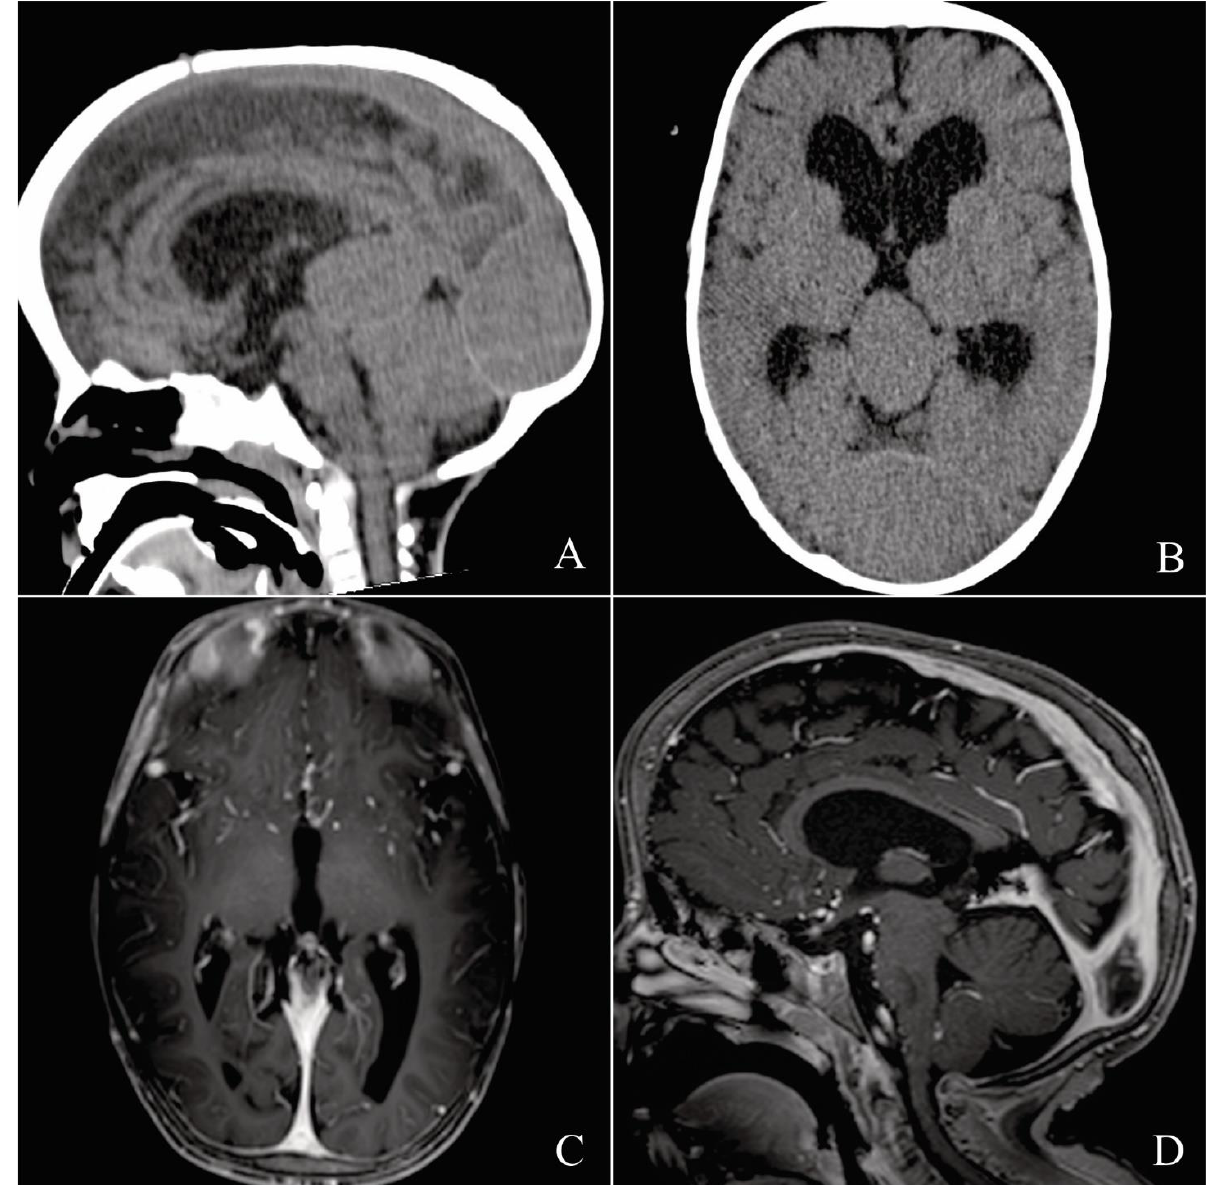
Figure 3 - Computed tomography scan of the brain at admission, sagittal view (A), and axial view (A) showing a dilated vein of Markowski and a dilated torcula. Magnetic resonance image of the brain 12 months after treatment axial view (C), and sagittal view (D) showing absence of the vein of Markowski and a reduction in size of the